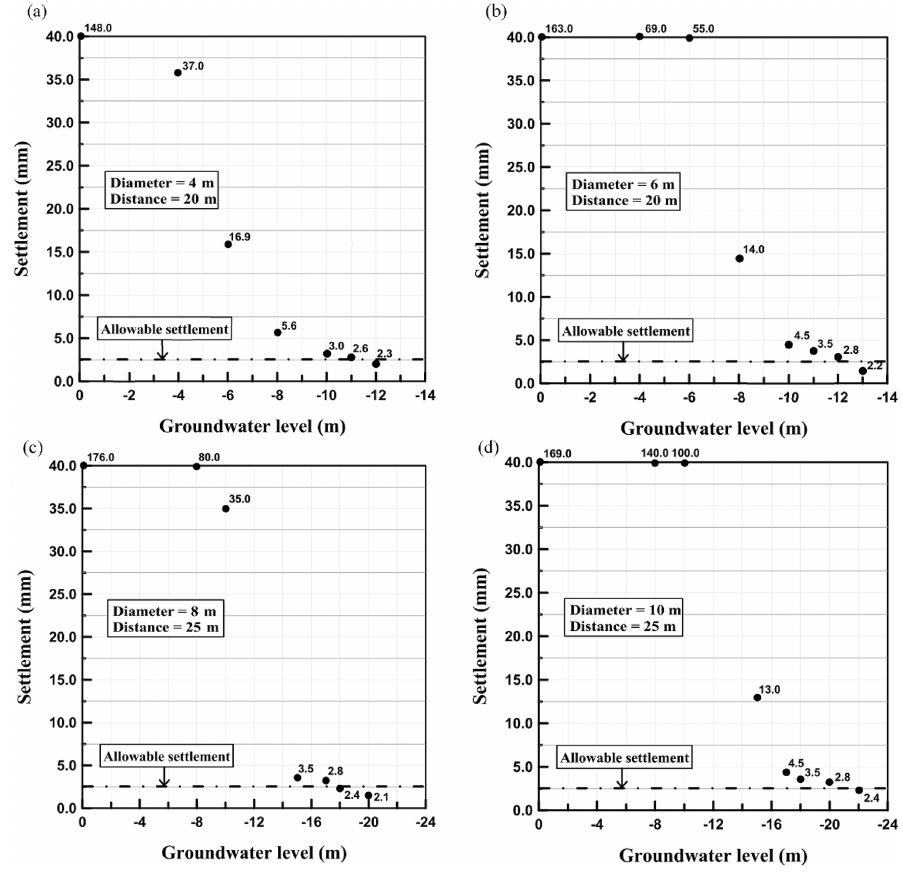
Figure 9. Roadbed settlement with respect to the groundwater level: (a) diameter of the cavity = 4m and distance of roadbed from the center of the cavity = 20m, (b) diameter of the cavity = 6m and distance of the roadbed from the center of cavity = 20m, (c) diameter of the cavity = 8m and distance of the roadbed from the center of cavity = 25m, and (d) diameter of the cavity = 10m and the distance of the roadbed from the center of the cavity =